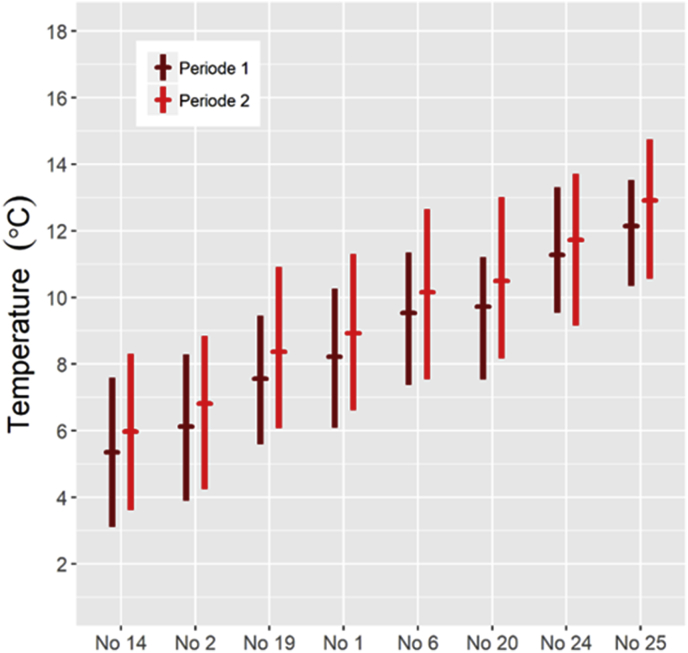
Calculated range and mean (horizontal bar) of temperature for June–August 1959–2018, at the average altitude of the main summer pasture areas for eight wild reindeer and red deer populations sampled for parasitological studies 2012–2014. The results are presented separately for the two 30-year periods 1959–1988 (brown symbols) and 1989–2018 (red symbols). Reindeer populations (No): 14 Nordfjella, 2 Snøhetta, 19 Setesdal Ryfylke, 1 Forollhogna, 6 Rondane, 20 Setesdal Austhei. Red deer populations (No): 24 Ørsta, 25 Kvinnherad. (For interpretation of the references to color in this figure legend, the reader is referred to the Web version of this article.)